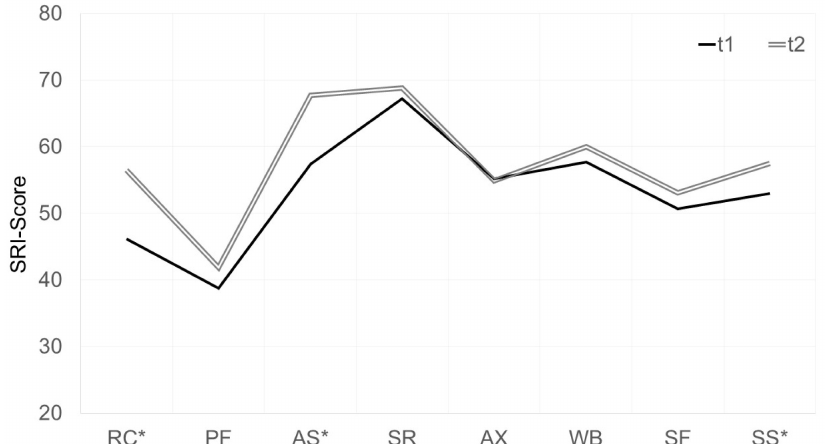
Figure 4. Domains of the Severe Respiratory Insufficiency Questionnaire (SRI). Notes: Higher scores (range, 0–100) indicate a higher HRQL. * Significant mean differences ( p ≤ 0.05) between t1 (prior non- invasive ventilation) and t2 (following 3 months of NIV). Abbreviations: RC: respiratory complaints; PF: physical functioning; AS: attendant symptoms and sleep; SR: social relationships; AX: anxiety; WB: psychological wellbeing; SF: social functioning; SS: summary